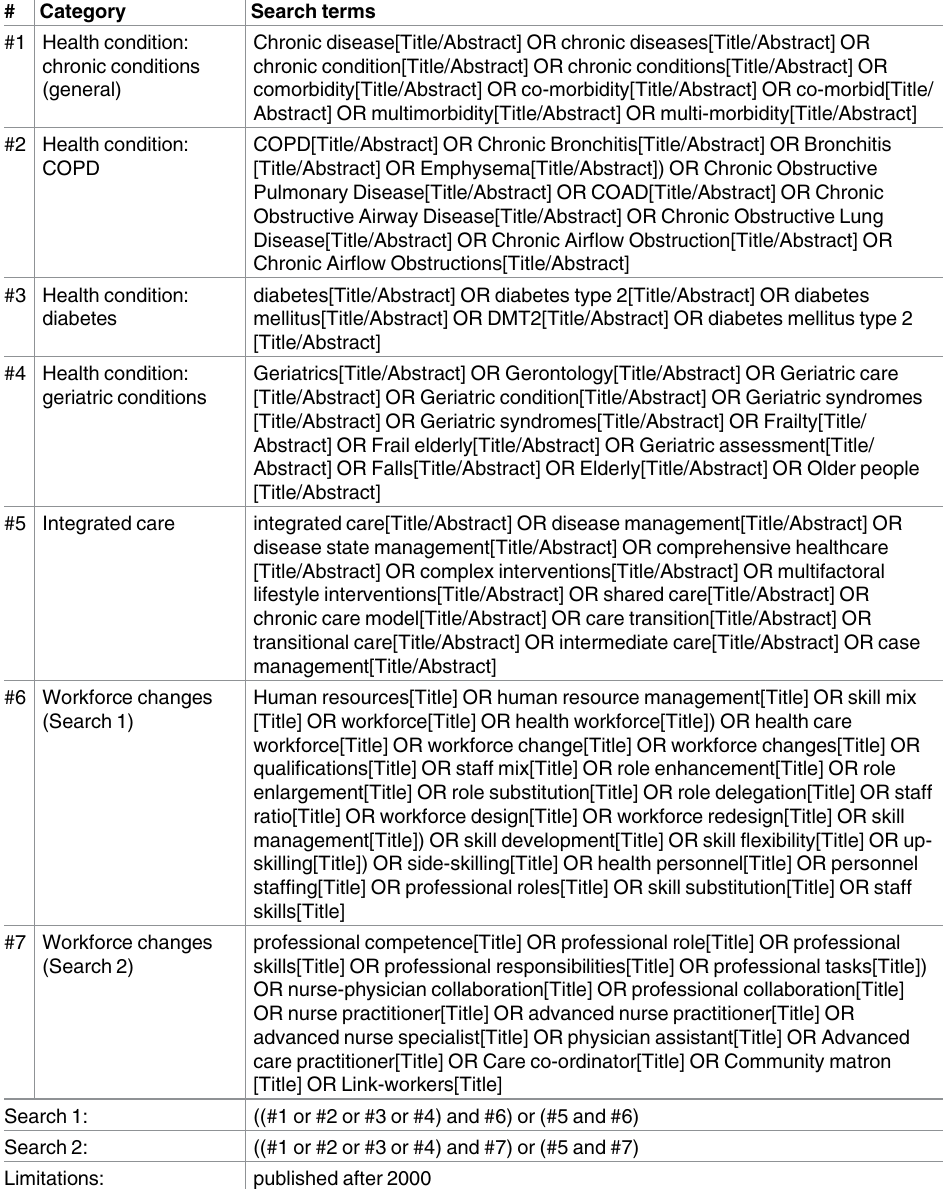
Table 1. Full search strategy for